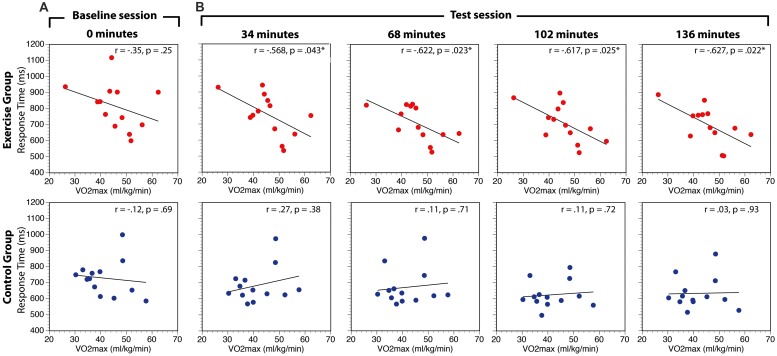
Correlations between VO2max and visual search RT at baseline (A) and during the test session (B). RT data are averaged across search task load and distractor interference conditions. While the p-values indicate the values uncorrected for multiple comparisons, *indicate the hypothesis tests that are p < 0.05 FDR-corrected for multiple comparisons.